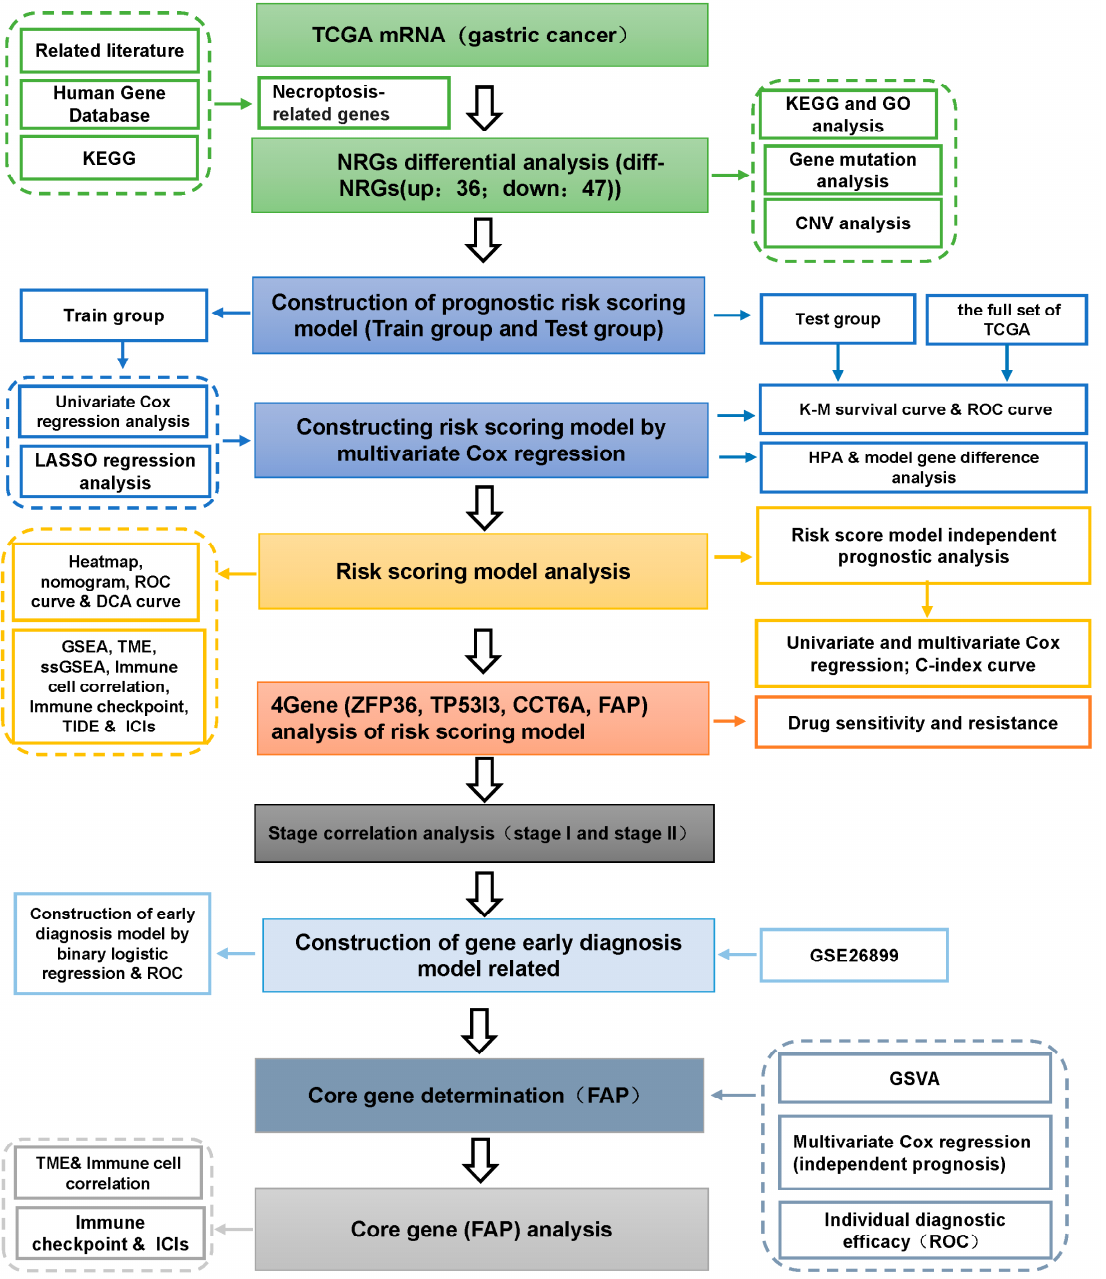
Figure 1. Flow chart. (NRGs: necroptosis-related genes; ICIs: immune checkpoint inhibitors; TME: mmune microenvironment; TCGA: the Cancer Genome Atlas; KEGG: Kyoto Encyclopedia of Genes and Genomes; Diff-NRGs: differentially expressed necroptosis-related genes; GO: Gene Ontology; CNV: copy number variation; LASSO: absolute minimum shrinkage and selection operator; K- M: Kaplan-Meier; ROC: receiver operating characteristic; HPA: Human Protein Atlas; C-index: concordance index; ssGSEA: single-sample enrichment analysis; TIDE: Tumor Immune Dysfunction and